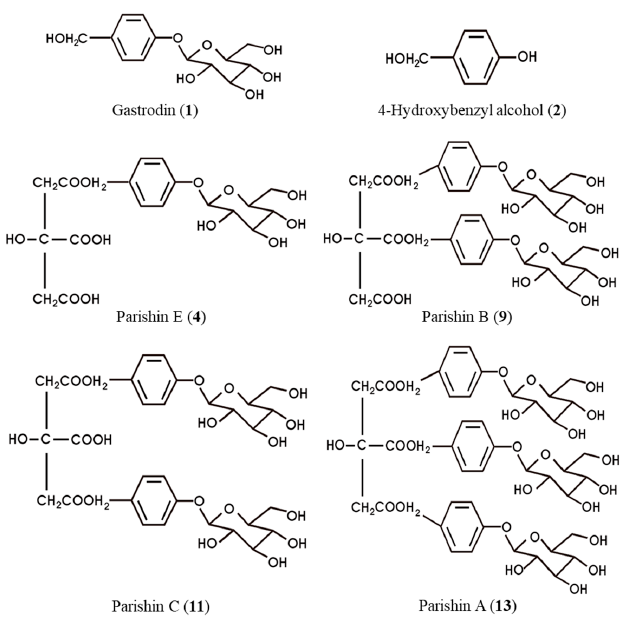
Figure 3. The proposed structures of parishin derivatives identified in M. tricuspidata fruit.